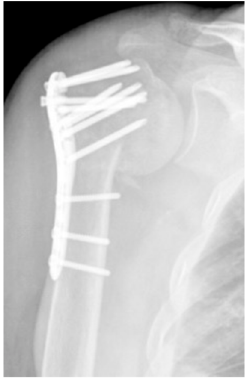
Figure 13. Complication Type 2c. a.p. radiograph of the right shoulder after angular stable plate osteosynthesis shows severe varus displacement of the humeral head. The most cranial screws penetrate the humeral head cortex, resulting in a screw cutout. The humeral head sintering appears unstable.